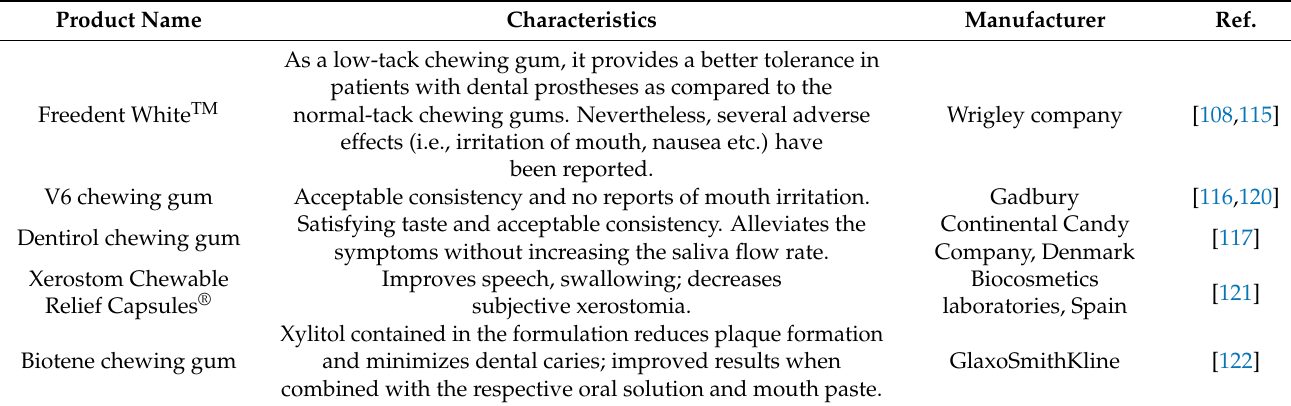
Table 4. Commercially available chewing gums used in